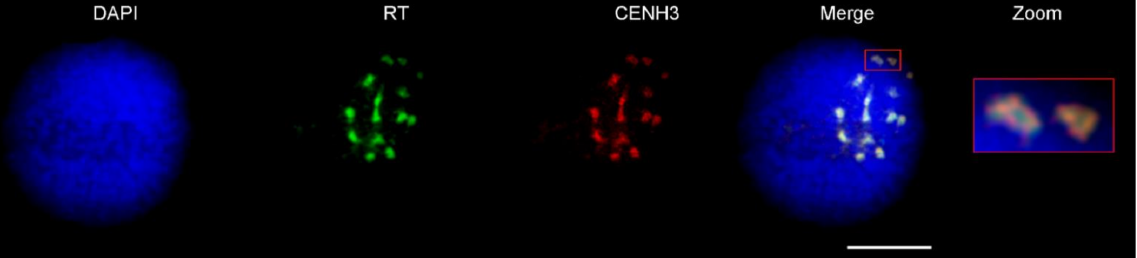
Figure 2. Colocalization of CENH3 with the Agrocen element in A. cristatum cv. Parkway. A combina- tion of the immunolocalization of the histone H3 variant CENH3 (red) and FISH on interphase nuclei with probes for the reverse transcriptase (RT) domain (green). Nuclei were counterstained with DAPI (blue). Bar corresponds to 10 µ